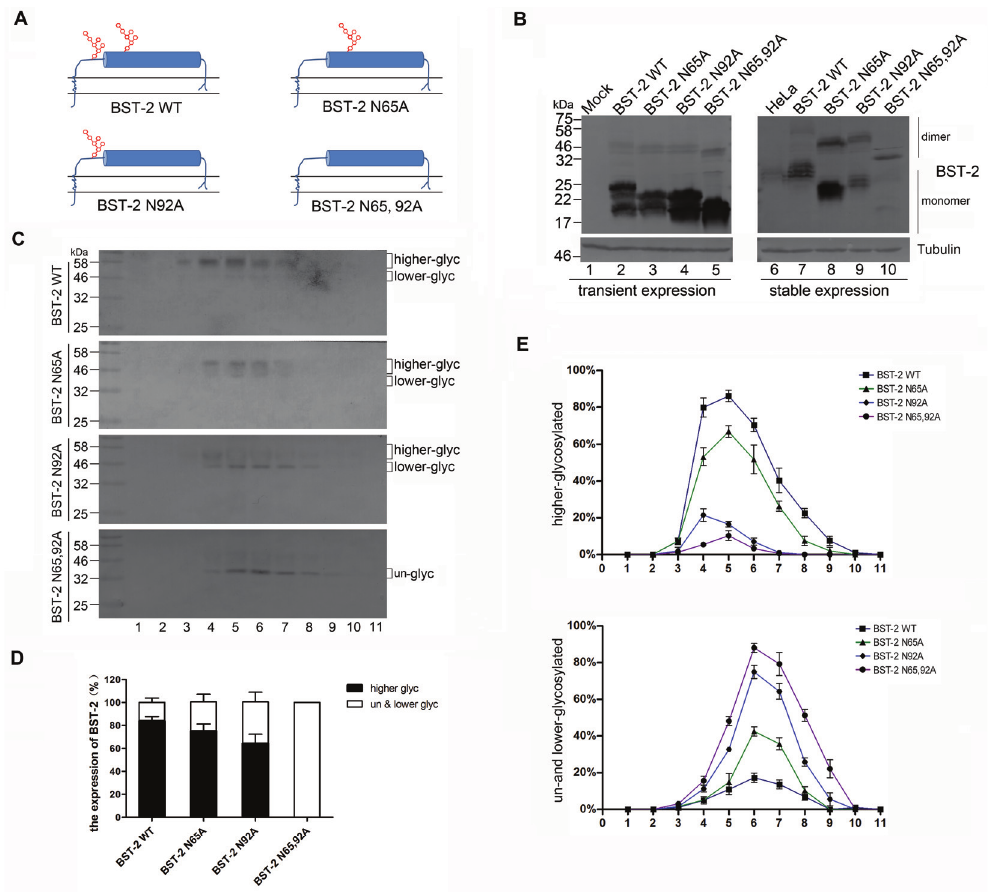
Figure 1. N-linked glycosylation affects subcellular distribution of BST-2. ( A ) Schematic representation of BST-2 variants. Glycosylation sites N65 and N92 are marked in red; ( B ) Comparison of post-translational modifications of transiently- and stably-expressed BST-2 variants. 293T cells were transfected with 200 ng of BST-2 variants. After 48 h, these cells and stably-transduced cells were analyzed by Western blotting using an anti-BST-2 mAb; ( C ) 293T cells stably expressing BST-2 variants in 10-cm dishes were lysed and analyzed by sucrose gradient ultracentrifugation. Samples were analyzed by Western blotting with an anti-BST-2 mAb; ( D ) Percentages shown in black and white columns, respectively, represented the levels of higher-glycosylated or lower-glycosylated and un-glycosylated BST-2 in panel C from three experiments. Levels of glycosylated patterns of BST-2 were quantified by the image J software Results were shown as mean ± SD; ( E ) Levels of glycosylated patterns of BST-2 in each sample in panel C from three experiments were quantified and plotted. Results were shown as mean ± SD. These experiments were repeated three times, and the most representative Western blot images are shown.